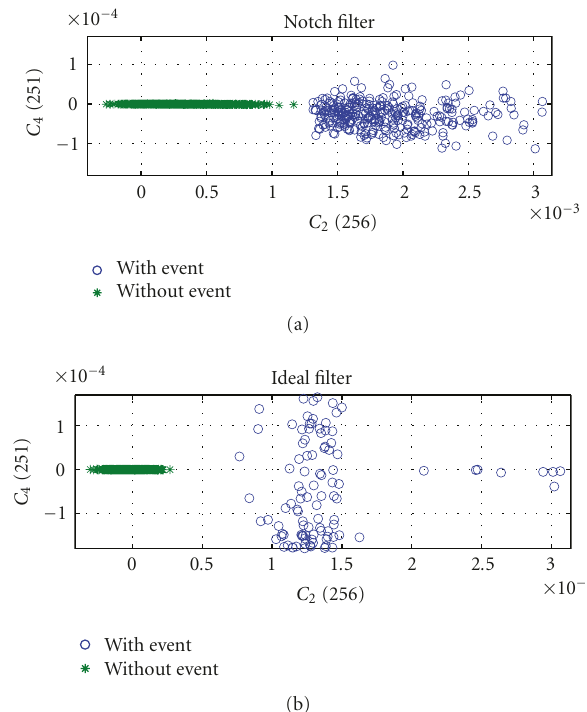
Figure 4: HOS-based features extracted from voltage signals whose frame length is equal to N = 128. For this frame length, second- and fourth-order statistics are extracted from u